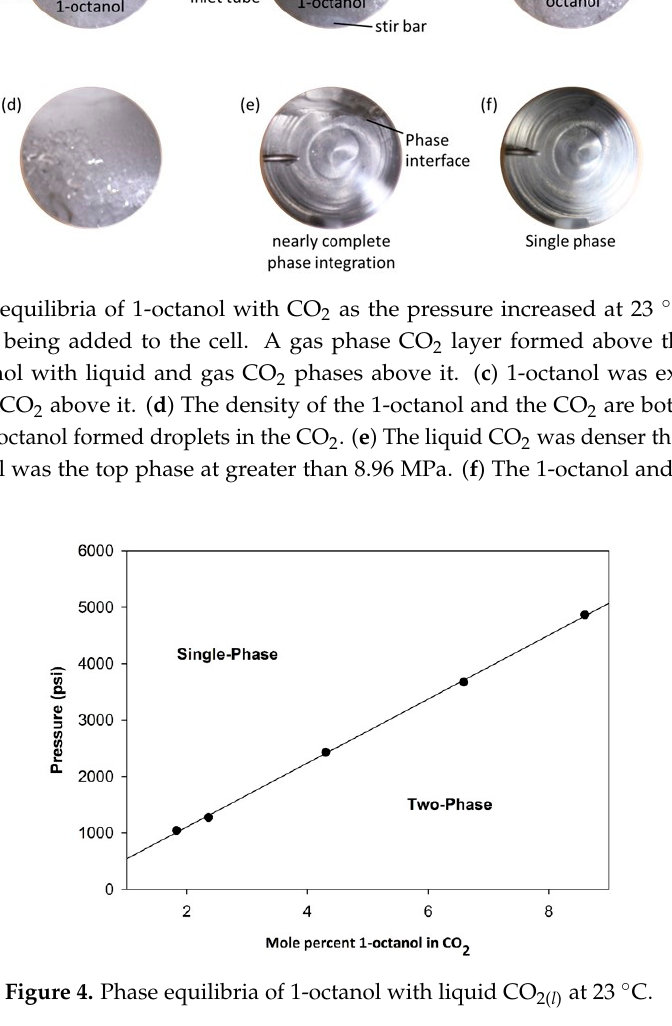
Figure 4. Phase equilibria of 1 ‐ octanol with liquid CO 2( l ) at 23 °C.